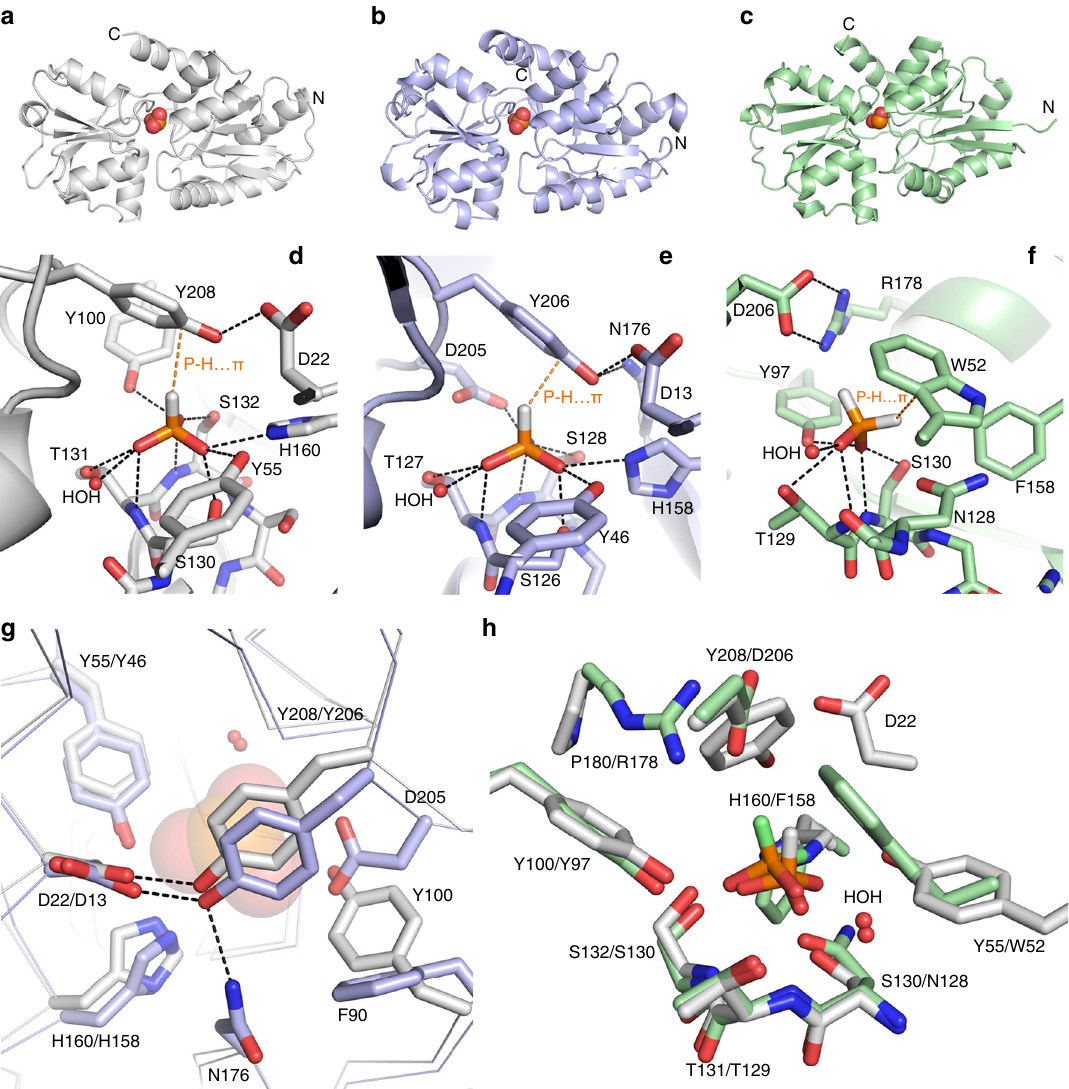
Fig. 1 The crystal structures of Te_PtxB and Pm_PhnD in complex with phosphite and HtxB in complex with hypophosphite. a – c A cartoon representation of the overall fold of Te_PtxB (grey, a ), Pm_PhnD (blue, b ) and HtxB (green, c ), with the ligand drawn as spheres and coloured in atom colours (N = blue, P = orange, O = red, S = yellow, H = white). The termini are labelled. See also domain topology diagram in Supplementary Fig. 6. d – f A detailed view of the ligand-binding pocket, highlighting the interactions made between the ligand and the protein for Te_PtxB ( d ), Pm_PhnD ( e ) and HtxB ( f ). The protein backbones are drawn as a cartoon, with the bound ligand and surrounding sidechains drawn as sticks, and coloured as in parts ( a – c ). The single buried water molecule (HOH) is drawn as a red sphere. Hydrogen bonds are drawn as dashed lines and the P-H … π interaction is drawn as an orange dashed line. g A superposition of Te_PtxB and Pm_PhnD, viewed from above the phosphite binding site, shows how exchanging Y100 in Te_PtxB for a phenylalanine (F90) in Pm_PhnD requires D205 to be recruited to complete the network of hydrogen bonds around the phosphite ligand. The phosphite is drawn as partially transparent spheres and the buried water molecule is indicated as a red sphere. h A comparison of the binding pockets of Te_PtxB and HtxB showing how the interactions around two of the P-oxygen binding sites are largely spatially conserved, but the third site is modi fi ed in HtxB (H160 to F158) to essentially block binding of a third oxygen moiety. The hydrogen atoms of the ligand are highlighted in green for HtxB and in white for Te_PtxB, with most of the main chain atoms omitted for